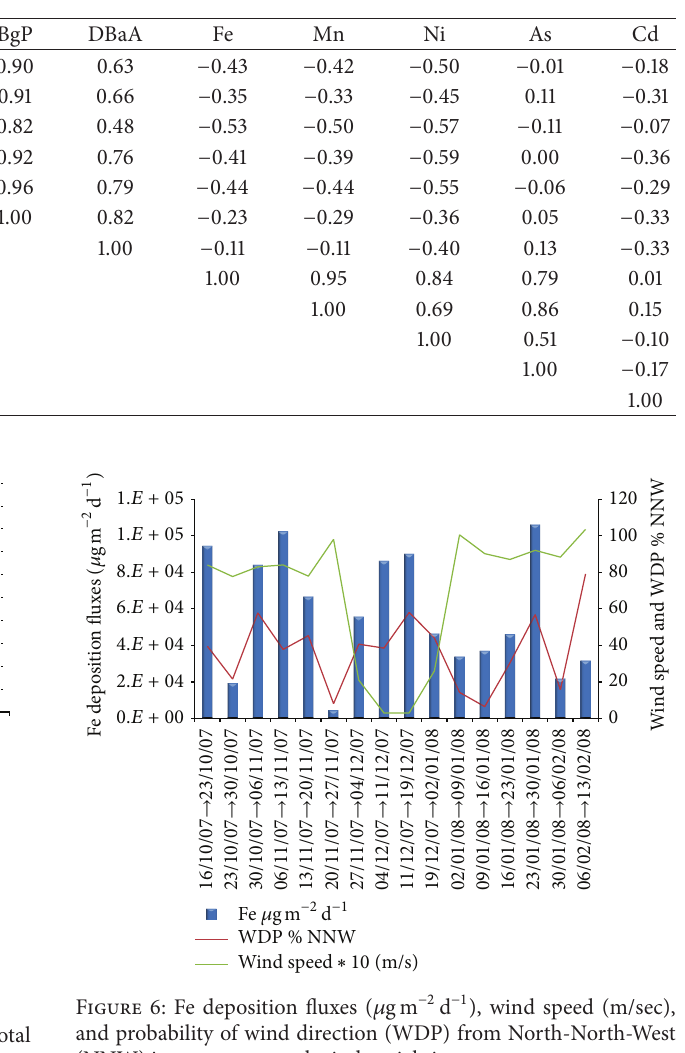
Table 6: Correlation coefficients among PAHs and metals collected at the urban background site.